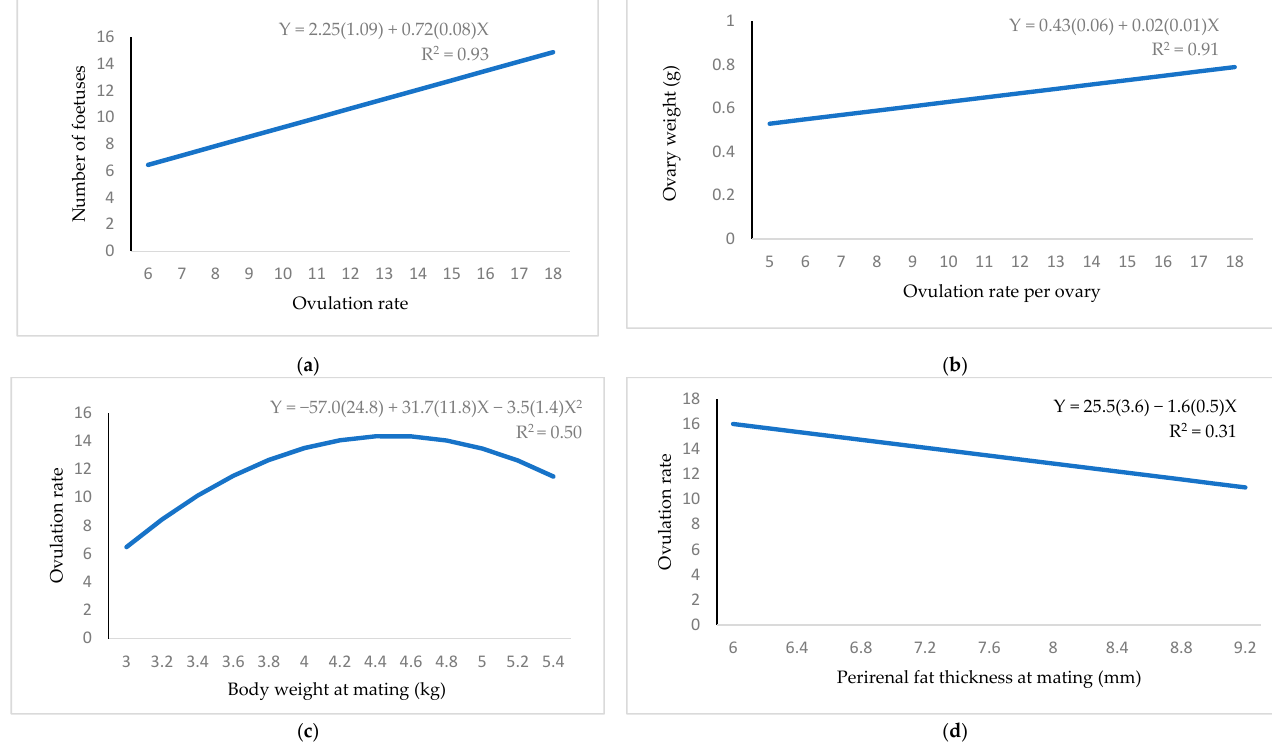
024681012141618 0.05 0.15 0.25 0.35 0.45 0.55 0.65